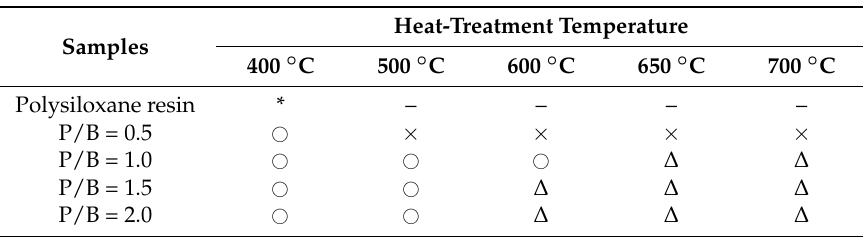
Table 1. The surface states for polysiloxane/Al coating after heat